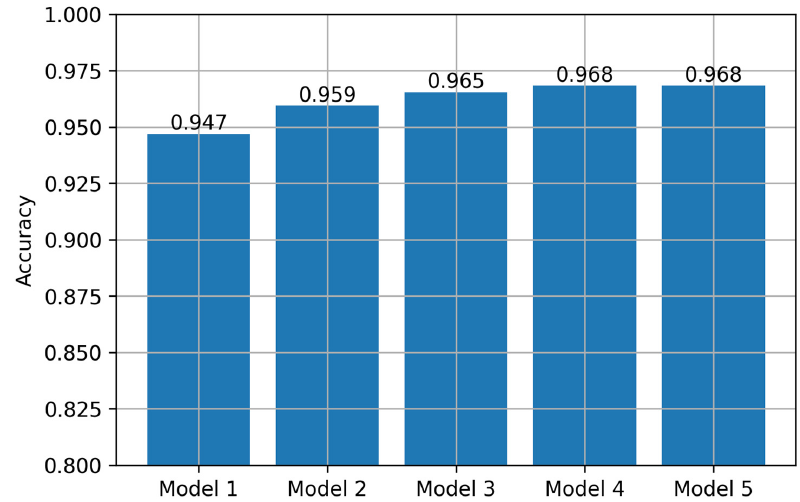
Figure 18. Accuracy of Xception models.